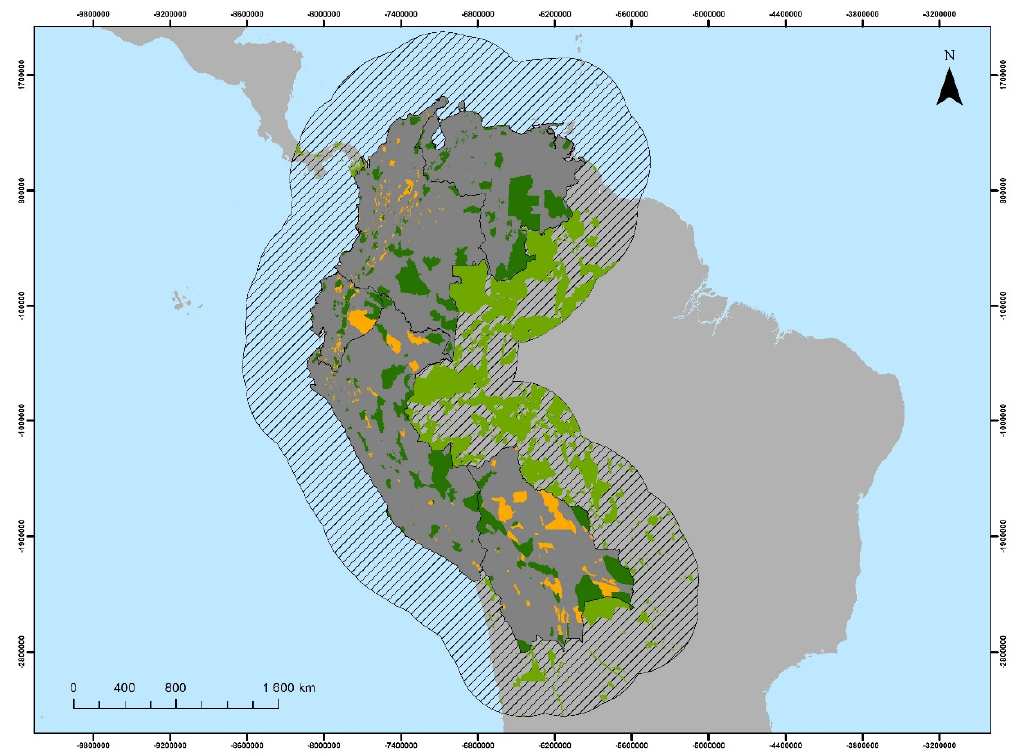
Figure A1. TAC study area in South America and national (dark green), subnational (yellow), and non-TAC transnational (light green) terrestrial protected areas considered in the analysis.